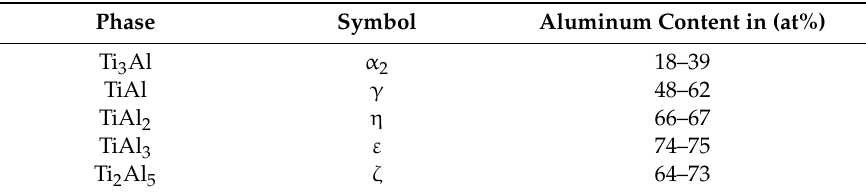
Table 3. Relevant intermetallic phases in binary Ti–Al phase diagram [24].